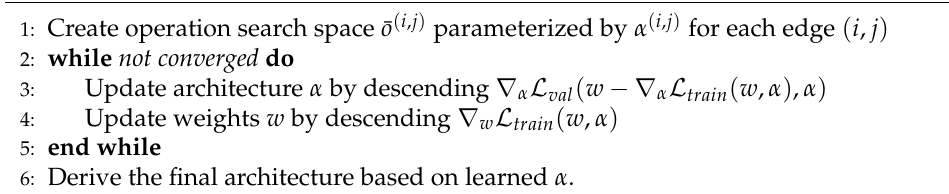
Algorithm 1 DARTS—Differentiable Architecture